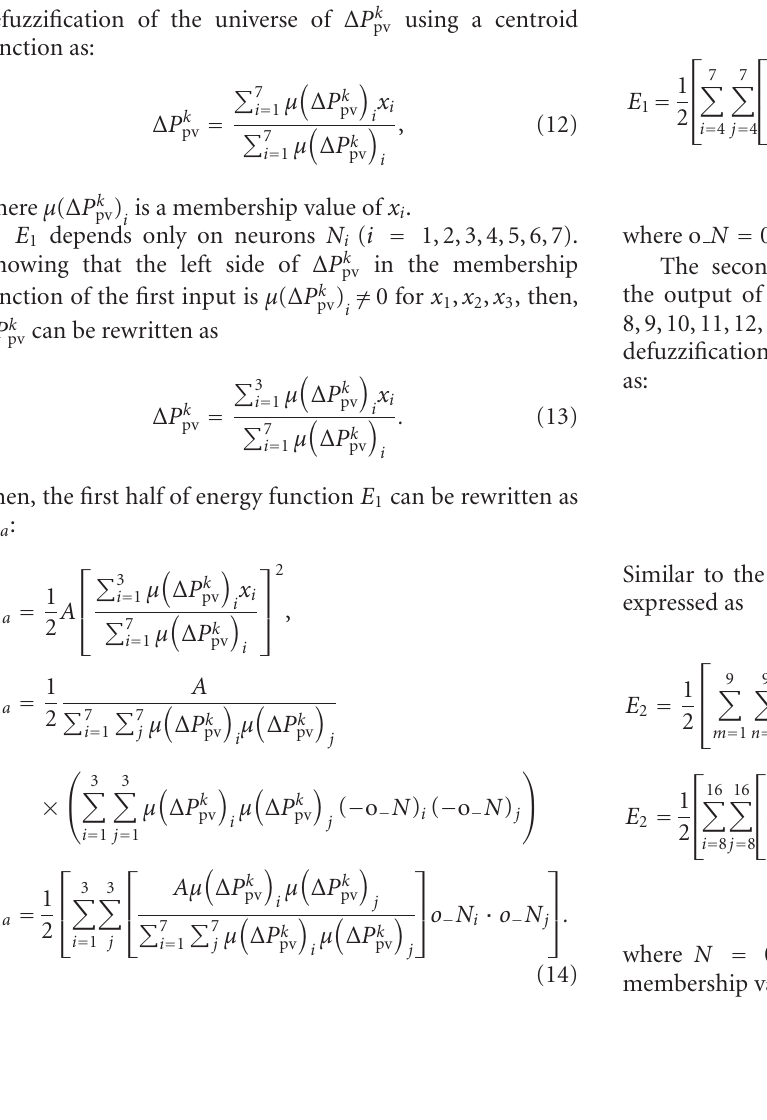
defuzzification of the universe of Δ P k